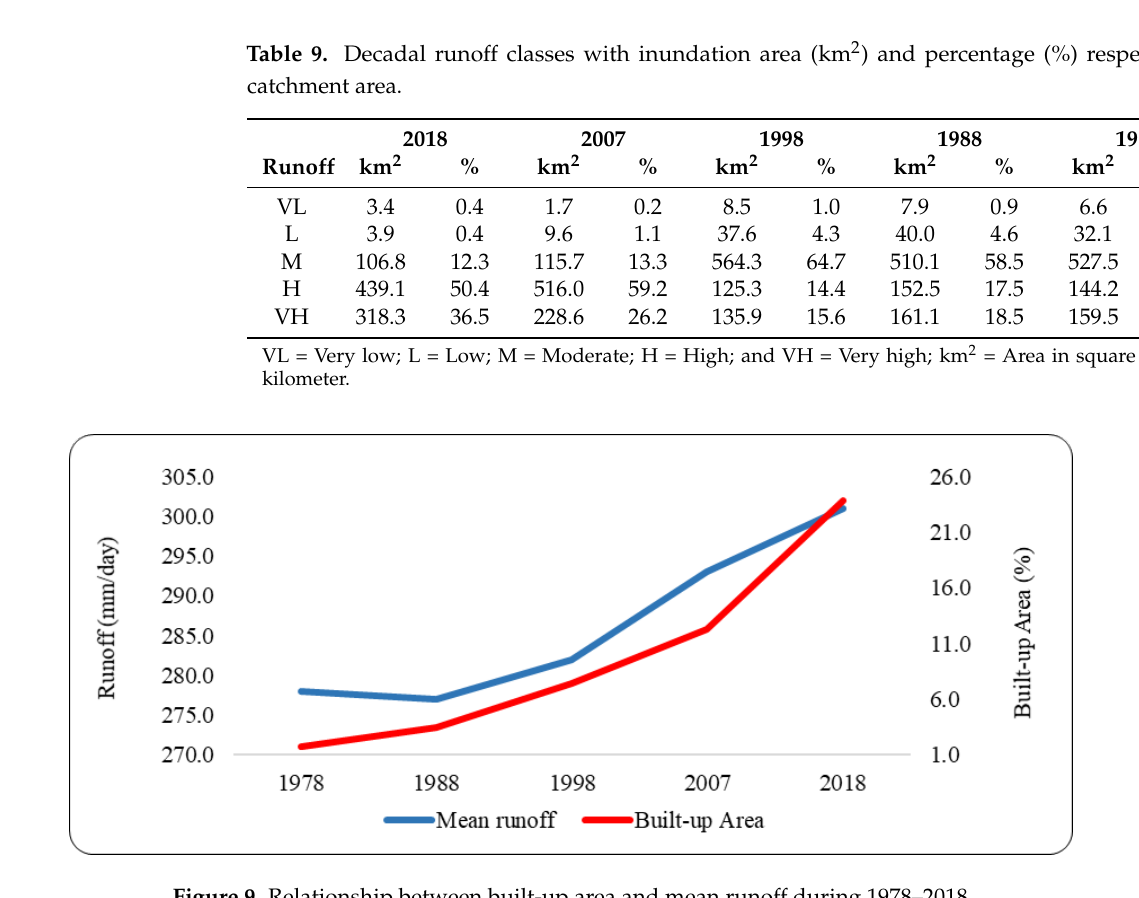
Table 10. Decadal runoff classes for Dhaka city with inundation area (km 2 ) and percentage (%) with respect to the city area.